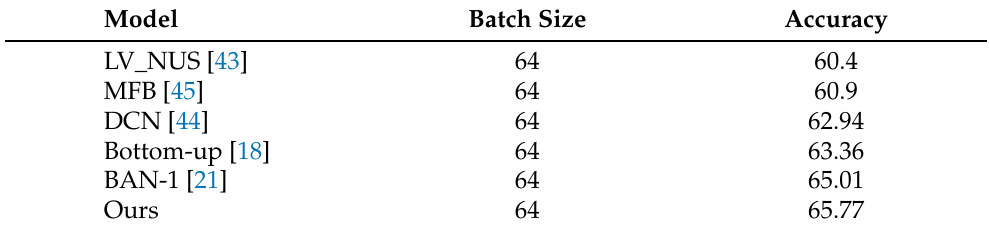
Table 2. Comparison of our model with several previous state-of-the-art models.